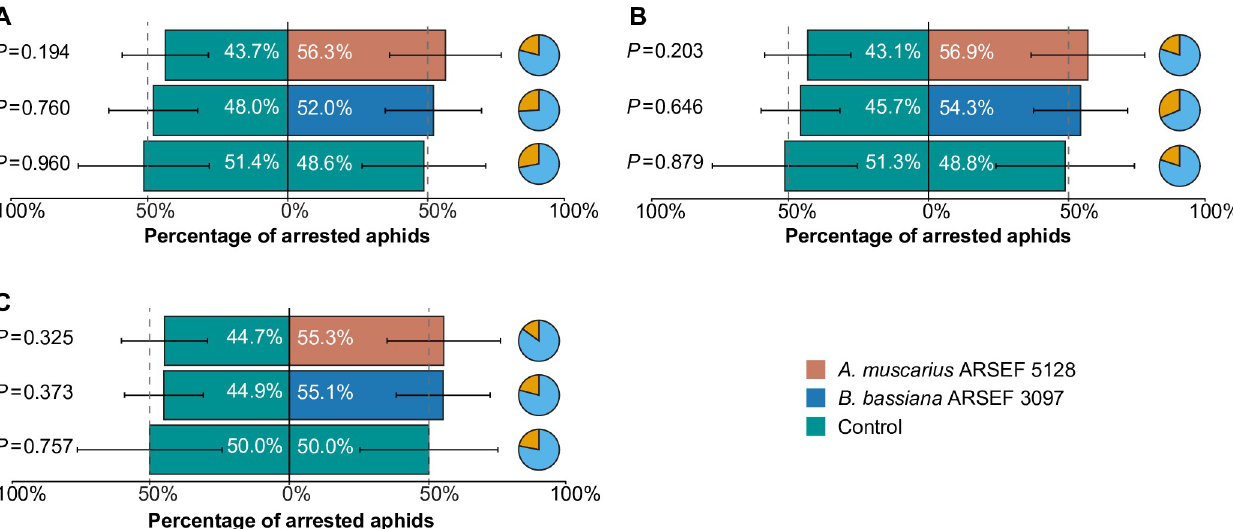
Fig 2. Behavioral response (attraction % ± SEM) of apterous Myzus persicae var. nicotianae when given the choice between sweet pepper plants inoculated with Akanthomyces muscarius ARSEF 5128 (orange) or Beauveria bassiana ARSEF 3097 (blue) and control plants (green), in a two-choice arena bioassay (tested in 20 cohorts of 10 adults for the fungal inoculated versus control assay, or 10 cohorts of 10 adults for the control versus control assay). Insect response was evaluated 4 (A), 8 (B) and 24 hours after aphid release (C). P values indicate differences in aphid response ( P � 0.05) when compared to a theoretical 50:50 distribution (Generalized Linear Mixed Model). Dashed lines indicate the 50% threshold. Pie charts show the percentage of responding (blue) and non-responding (orange) aphids. Overall aphid responsiveness was 77.3%.